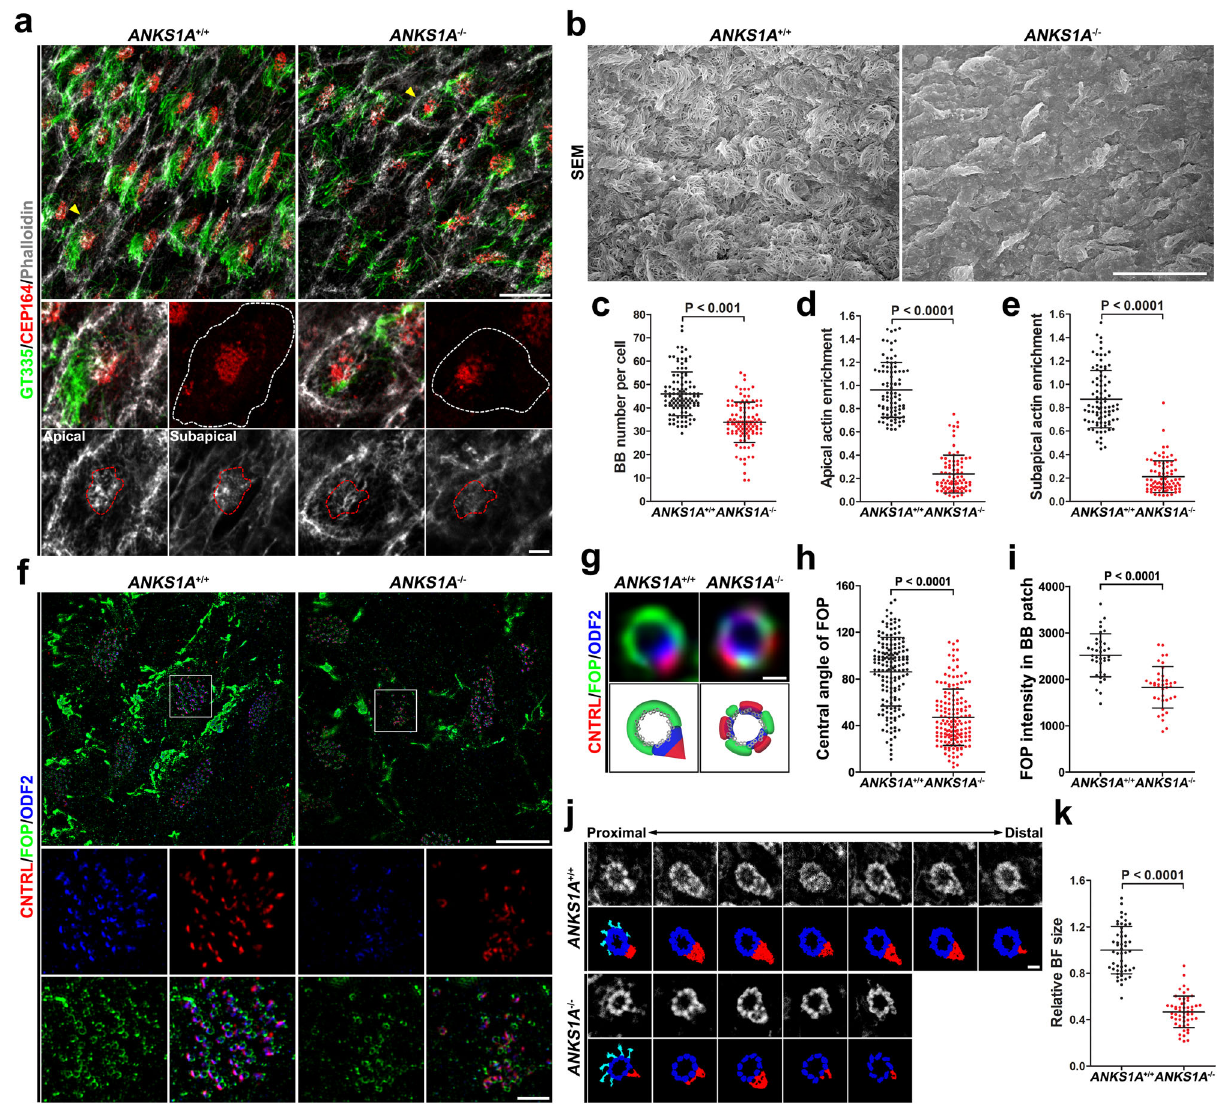
Fig. 6 ANKS1A loss results in severe SDA degeneration in aged mice. a Confocal microscopic analysis of LWs from littermates at 22 months of age (top panels). A representative cell (marked by yellow arrowheads) in each panel is enlarged to reveal motile cilia (green), BBs (red) (middle panels), and F-actin (gray) at the apical and subapical levels (bottom panels). The cell border and actin network around a BB patch are outlined with white and red dotted lines, respectively. b An SEM analysis of LWs from littermates at 22 months of age. Scale bar for a , b , 10 μ m. c – e Data from a were quanti fi ed. The mice used for this quanti fi cation ranged from 18 to 22 months of age. For c : ANKS1A + / + set, n = 110 cells from 4 mice; ANKS1A − / − , n = 113 cells from 4 mice. For d , e : ANKS1A + / + group, n = 87 cells from 4 mice; ANKS1A − / − , n = 85 cells from 4 mice. f 3DSIM micrographs of LWs depict triple staining with FOP, ODF2, and CNTRL. White boxes indicate the regions of ×3 magni fi cation that reveal SDA staining with each antibody (second and third panels). Scale bar, 10 μ m. g Representative SDA images (top) together with their cartoon depiction (bottom). Scale bar, 200 nm. h The central angles were calculated. ANKS1A + / + set, n = 164 BBs from 3 mice; ANKS1A − / − , n = 160 BBs from 3 mice. i Data in f were quanti fi ed. Data represent mean ± SD. ANKS1A + / + group, n = 50 cells; ANKS1A − / − , n = 56 cells. j , k A ribbon of consecutive sections (50 nm) was placed on a one-hole grid and subsequently analyzed by TEM. The resulting micrographs were aligned to measure the overall BF size. Data represent mean ± SD. ANKS1A + / + set, n = 50 BBs; ANKS1A − / − , n = 54 BBs. Scale bar, 100 fi laments were not signi fi cantly disturbed even in the aged KO mice (Fig. 7i, j).